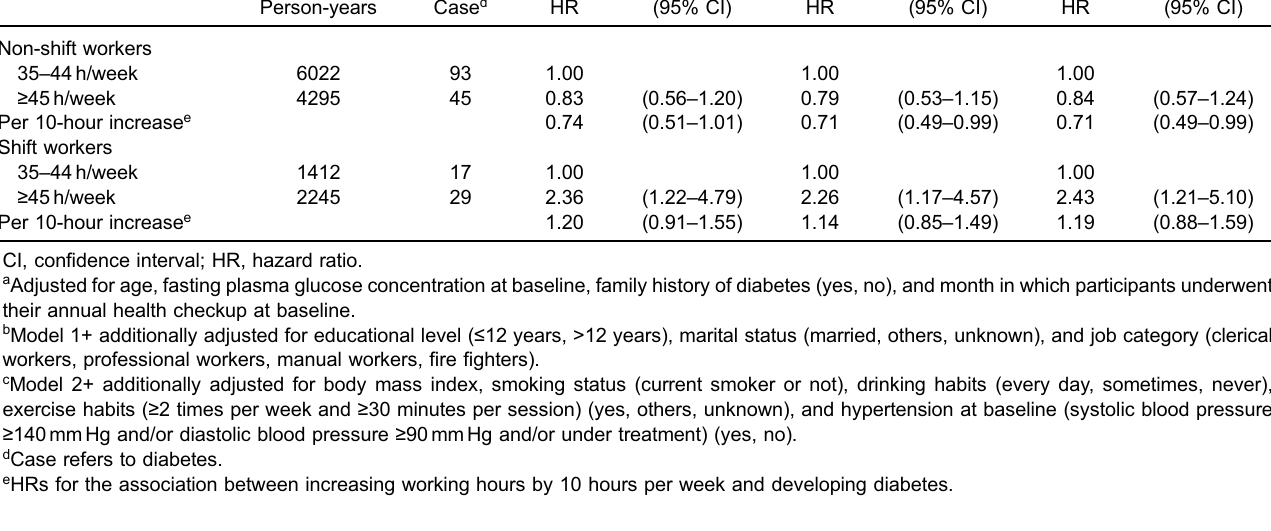
Table 2. Hazard ratios for the incidence of diabetes associated with long working hours by shift work schedules among all participants (non-shift workers n = 2371, shift workers n = 824) Working